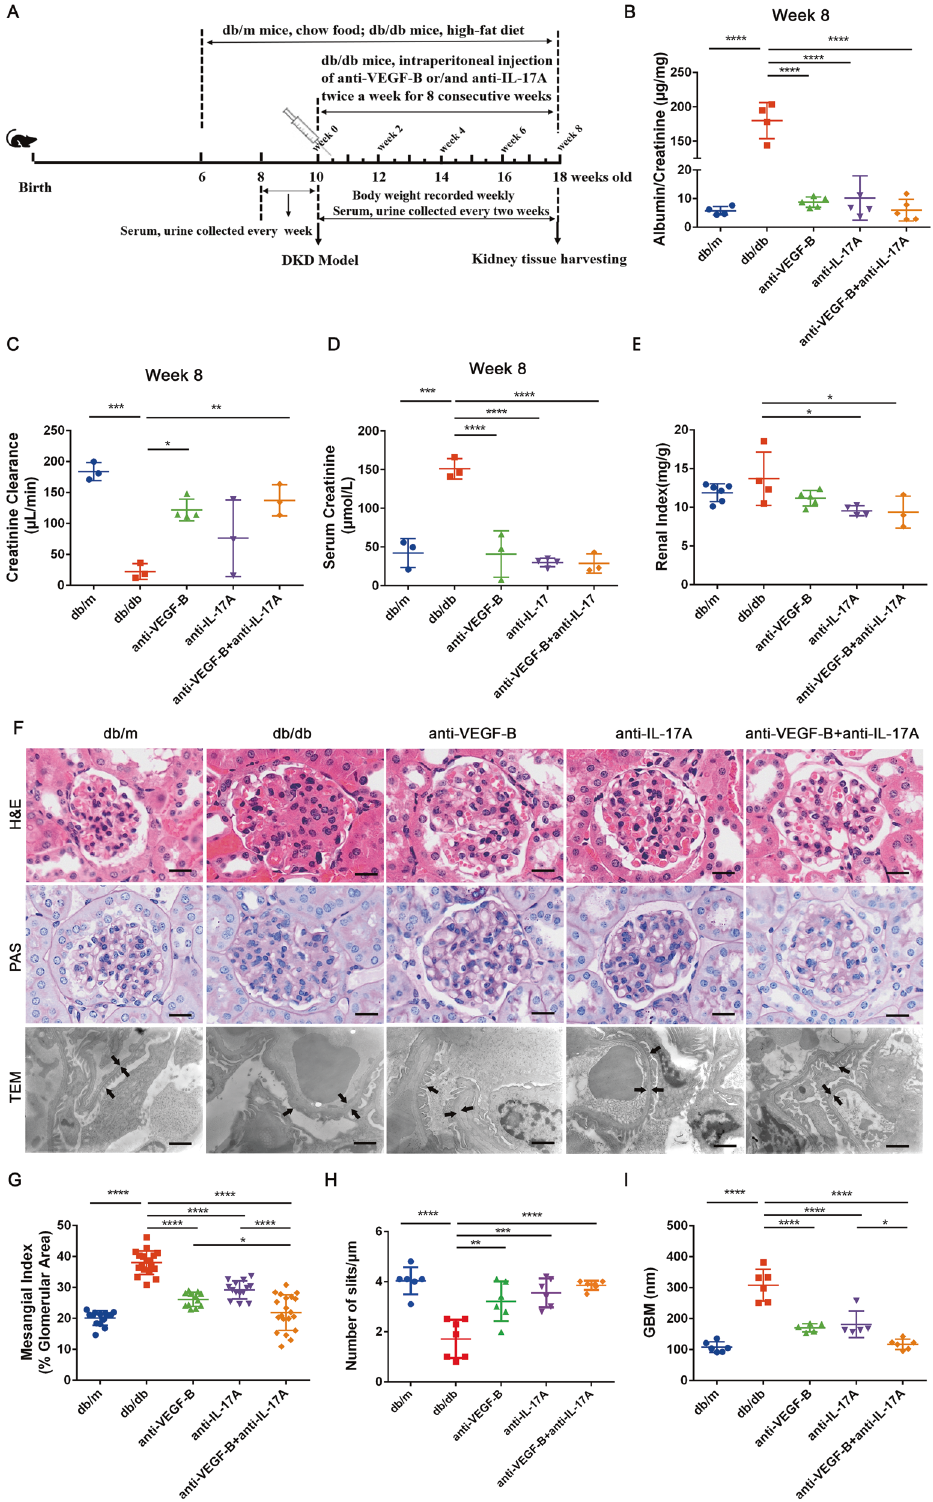
combined therapy of anti-VEGF-B and anti-IL-17A (Fig. 2H), the glomerular basement membrane thickness in db/db mice was also obviously decreased (Fig. 2I). The body weight of db/db mice was signi fi cantly heavier than that of db/m mice, there were no differences among treated